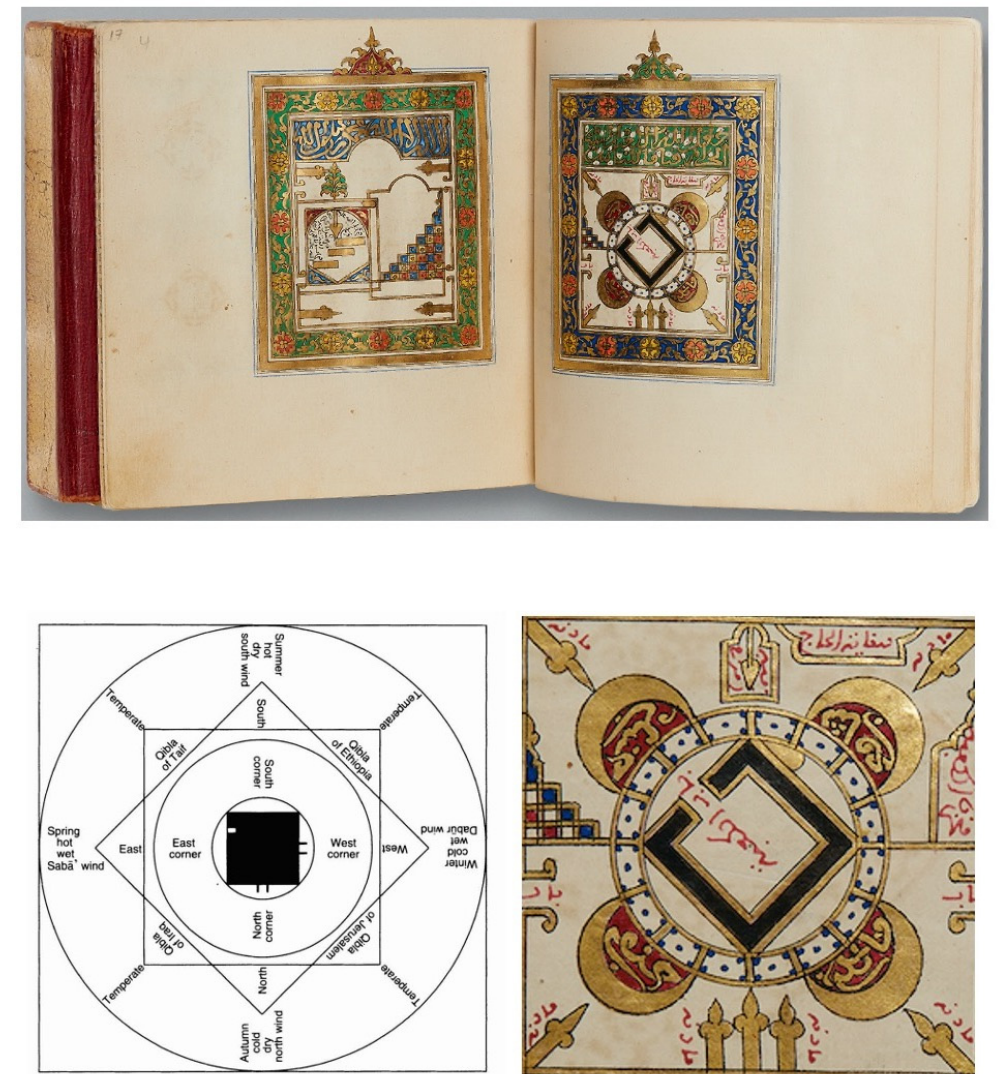
Figure 8. Dal ʾ il al-khayr ā t , 19th century ( above ). Manuscript of Dala’il al-Khayrat Prayerbook, North Africa, probably Morocco, 19th century, opaque watercolor, gold and ink on paper, H. 13.2 cm × W. 13.8 cm × D. 5.9 cm, AKM535 © Aga Khan Museum. Licensed under CC BY-NC 2.5 CA, Comparison between the image of al-Masjid al-Haram in Dal ʾ il al-khayr ā t and the four-sector Islamic sacred geography ( below ).